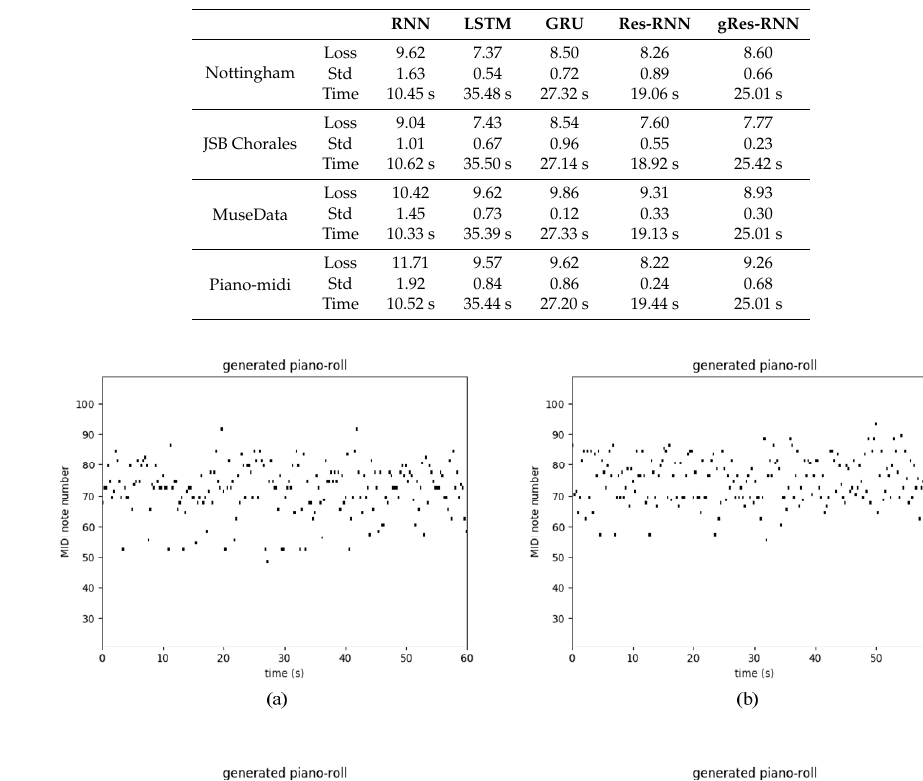
Table 3. Average performance of the RNN [9], LSTM [16] and GRU [17] and Res-RNN and Res-RNN with gates on different polyphonic databases in 10,000 epochs.